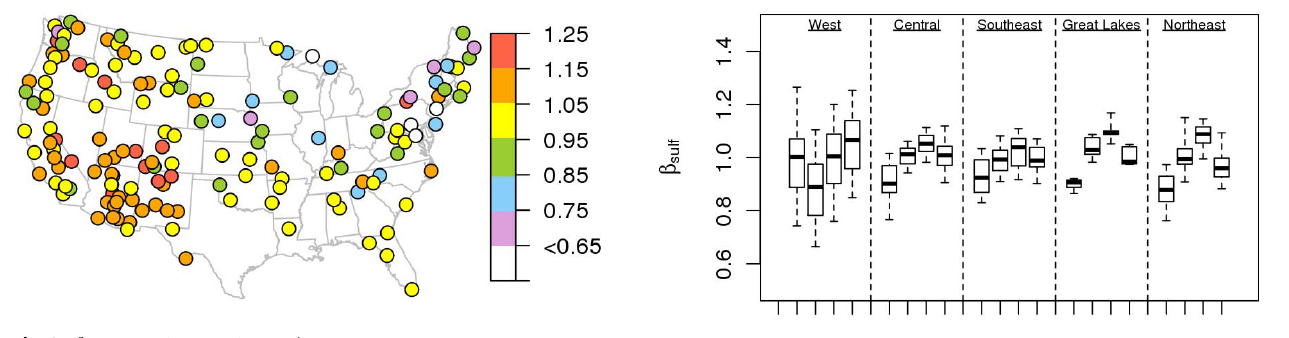
Fig. 8. β soil at 153 IMPROVE sites.